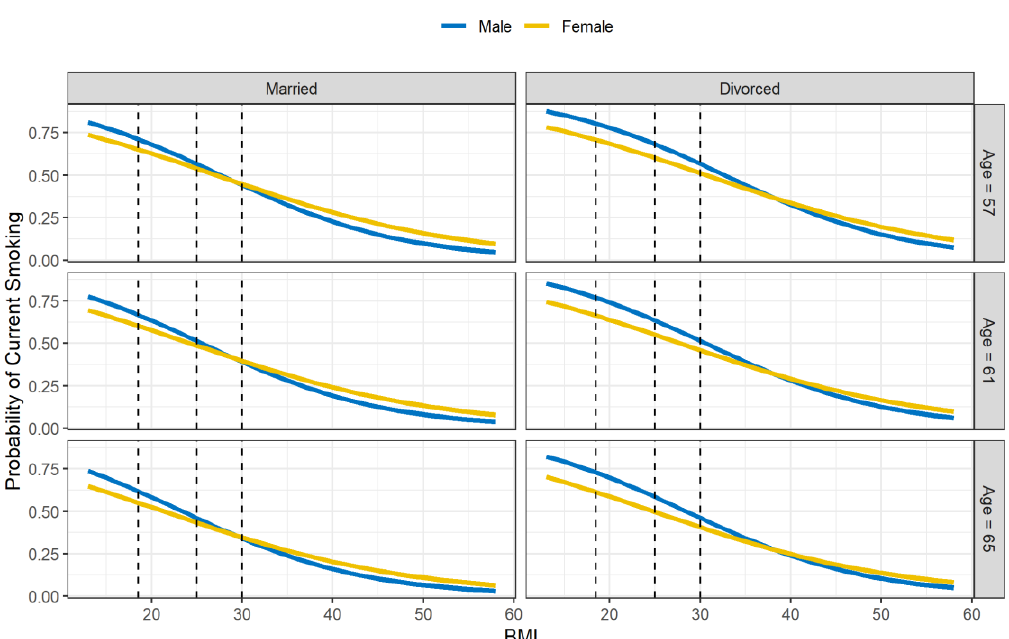
Figure 3. Probability of current smoking by BMI, gender, marital status (columns) and age (rows). Age values are the quartiles of the sample. Curves are predicted values based on the penalized logistic regression. Vertical dashed lines are the CDC classifications of underweight, healthy, overweight, and obese (left to right).